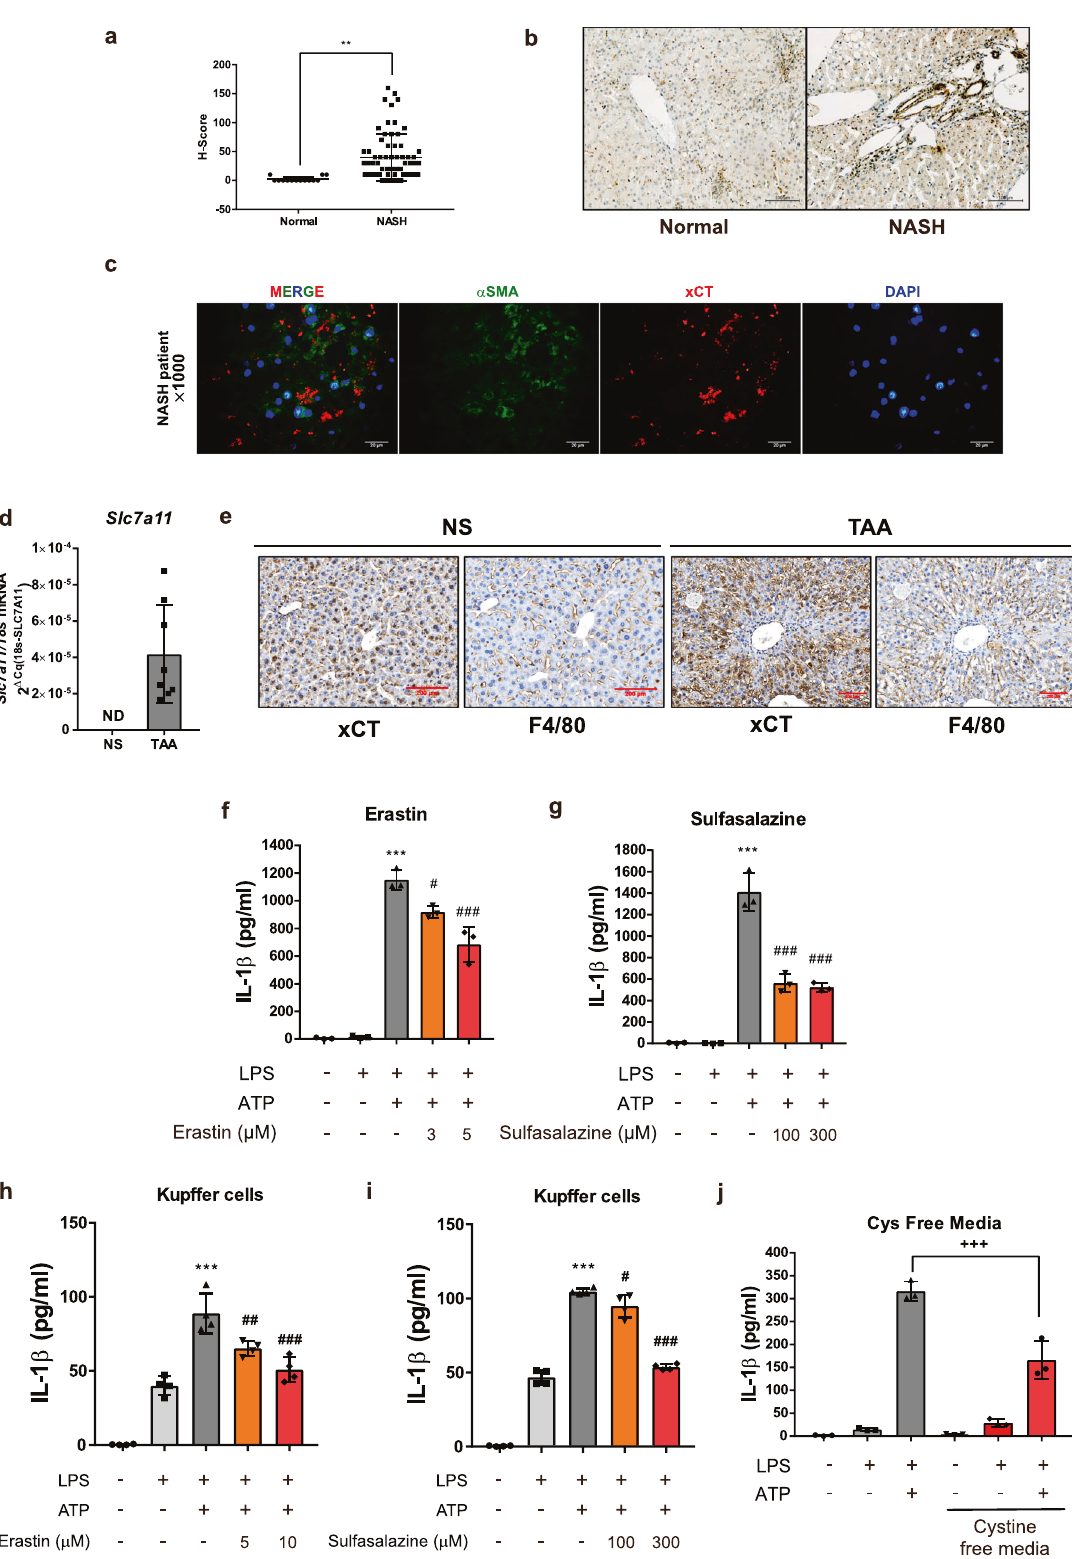
steatohepatitis whose pathological stage preceded liver fi brosis. The enhanced level of system Xc activity in liver tissues was mainly localized in macrophages and HSCs. These data support the notion that the anti-liver fi brotic effect of aurano fi n may result from system Xc -mediated inhibition of the NLRP3 in fl ammasome in macrophages and HSCs. When we determined